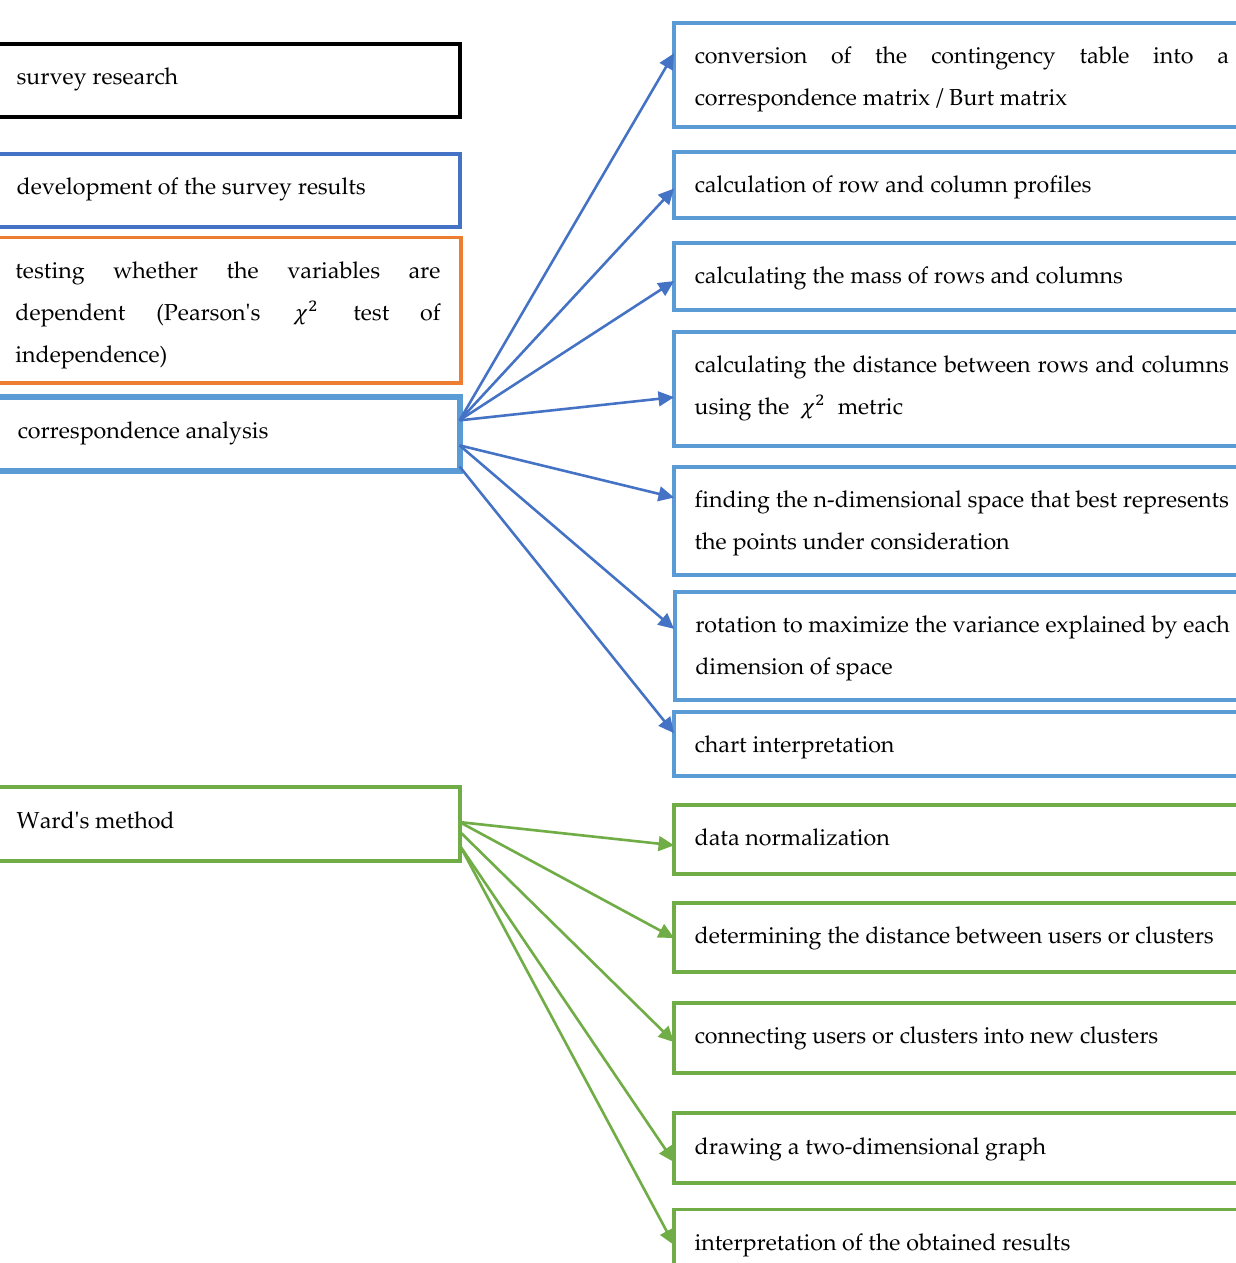
Figure 10. Diagram of the methodology.